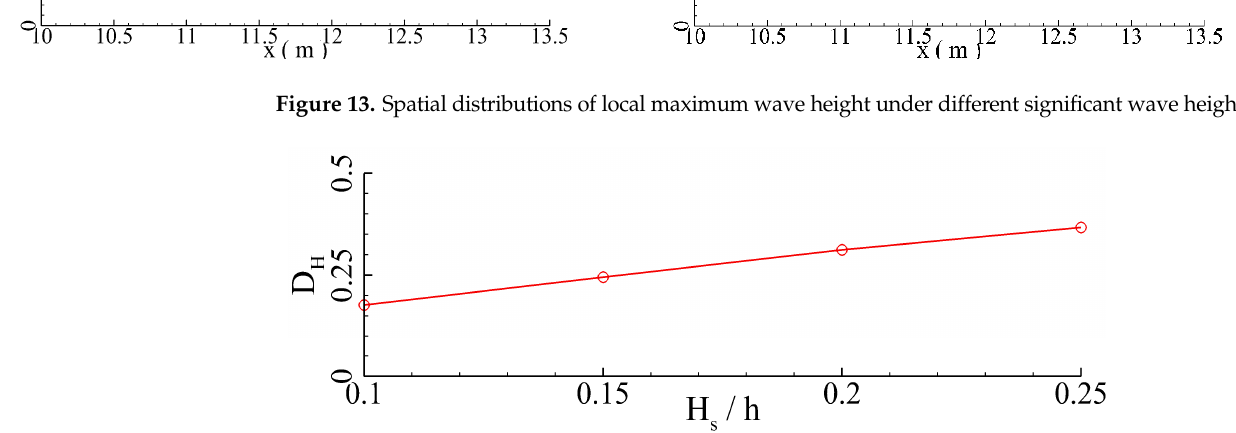
Figure 14. Decreasing rate of the local maximum wave height at the rear side of the vegetation patch under different significant wave heights.